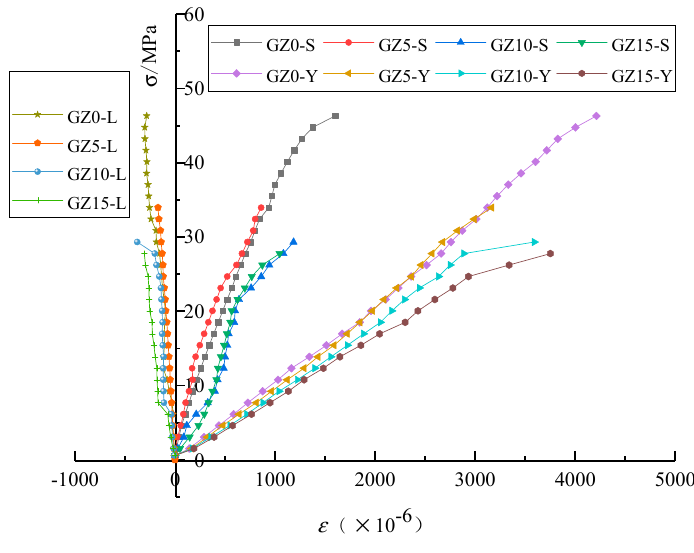
Figure 11. The curves of σ - ε .